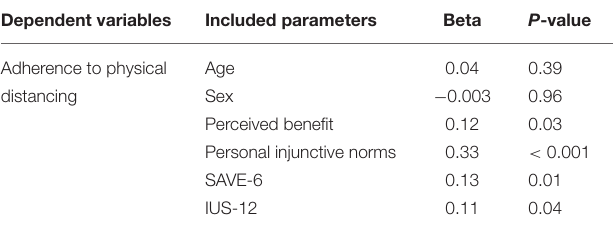
TABLE 4 | Linear regression analysis to explore the predicting factors for adherence to physical distancing among healthcare